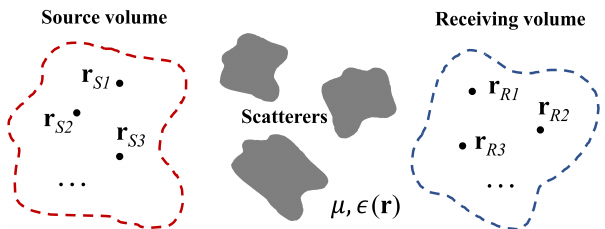
Figure 1. A general model of a MIMO system in an isotropic inhomogeneous environment. Transmit- ting antennas at the positions r Sn ( n = 1, . . . , N S ) are distributed in the source volume, and receiving antennas at the positions r Rm ( m = 1, . . . , N R ) are distributed in the receiving volume. The permeabil- ity of the environment is µ and the permittivity is (cid:101) ( r ) characterizing arbitrary